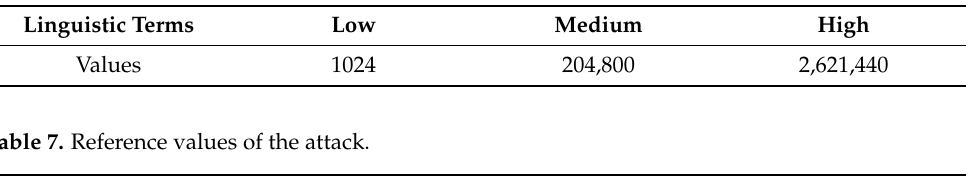
Table 6. Reference values of the transferred bytes difference.